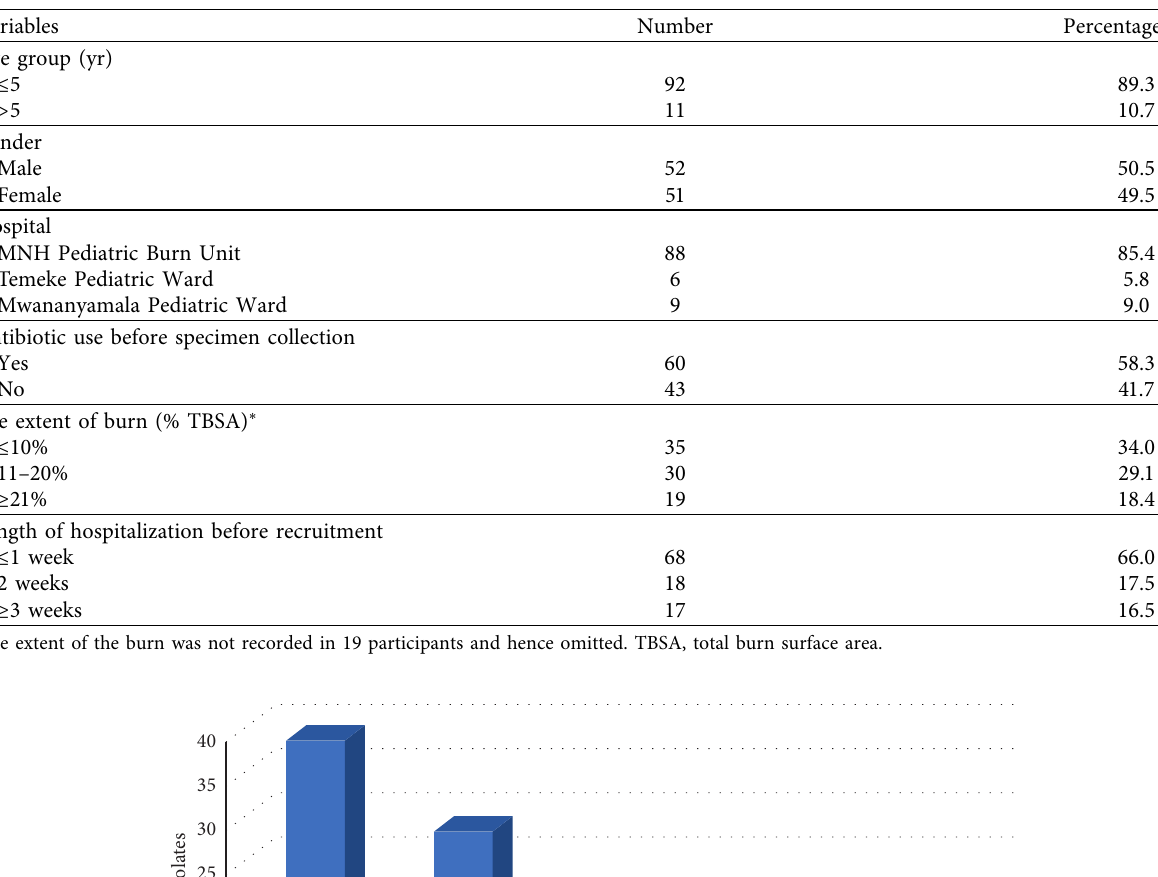
Table 1: Characteristics of pediatric patients with burn wound